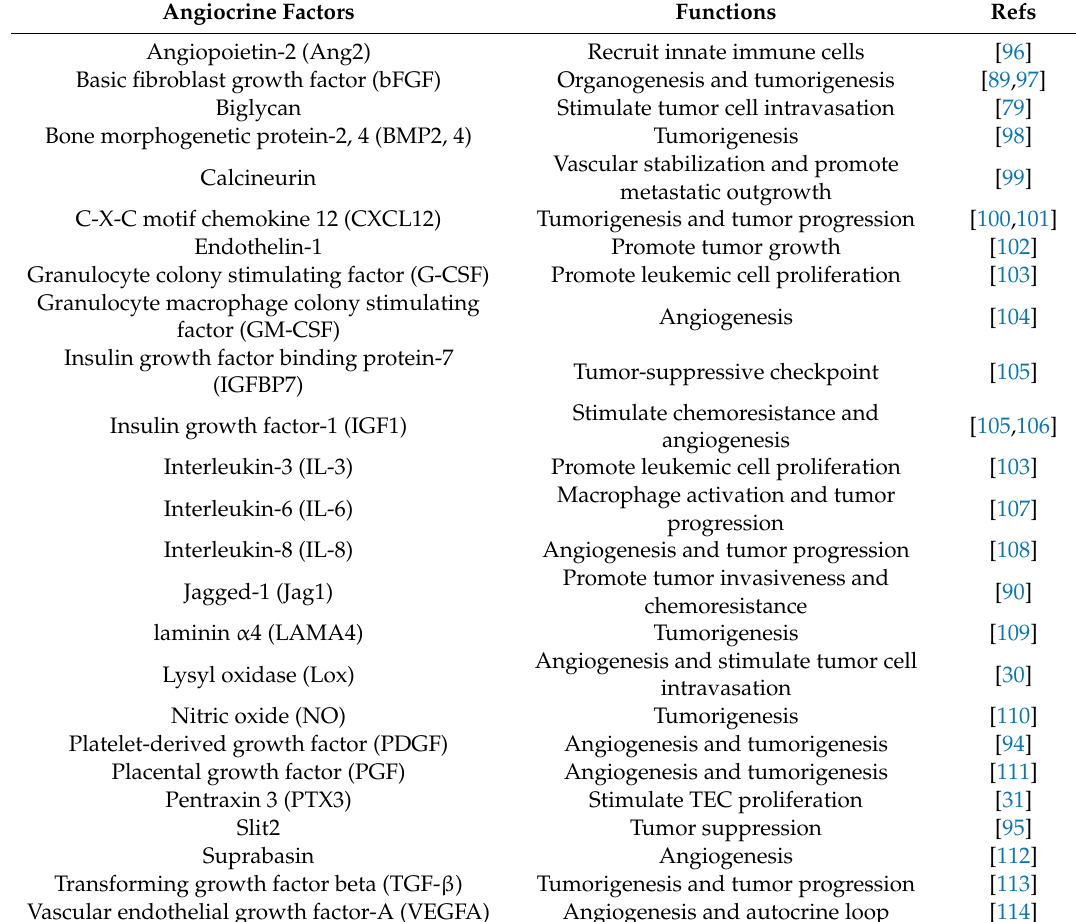
Table 1. Angiocrine factors produced by tumor endothelial